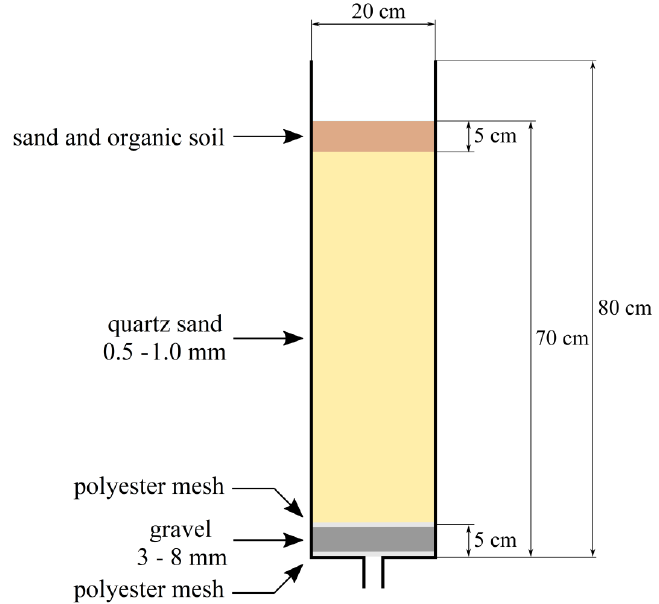
Figure 1. A scheme of experimental CW column.